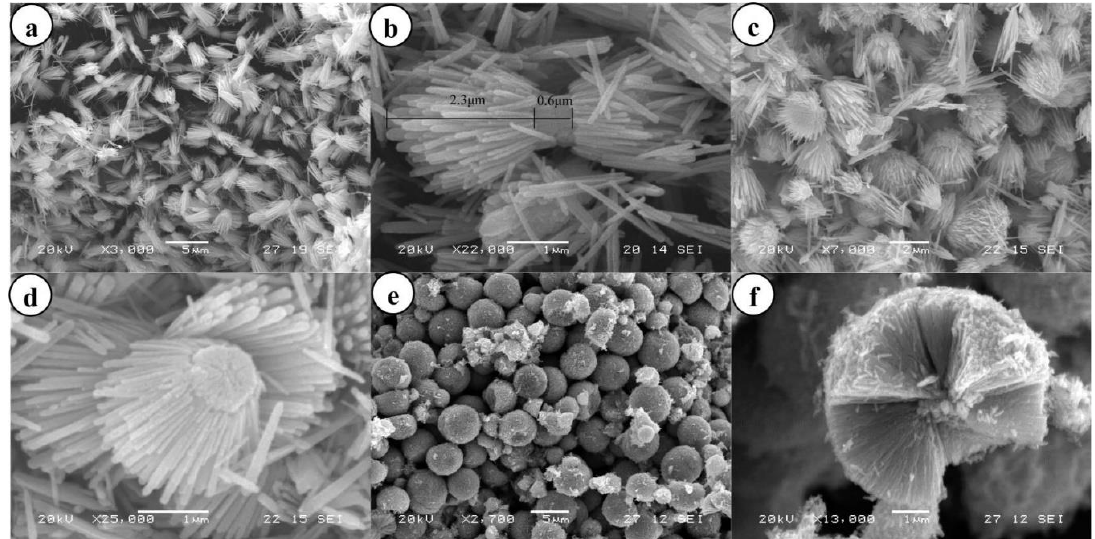
Figure 40. ( a , b ) Low- and high-magnification SEM images of the straw-bundle-like ZnO, ( c , d ) low- and high-magnification SEM images of the wide chrysanthemum-like ZnO, ( e ) low-magnification SEM image of the nanorod-based microspheres, ( f ) high-magnification SEM image of a typical broken microsphere. Reprinted (adapted) with permission from [761]. Copyright © 2008, American Chemical Society. All rights reserved. In order to re-use permission must be obtained from the rightsholder.